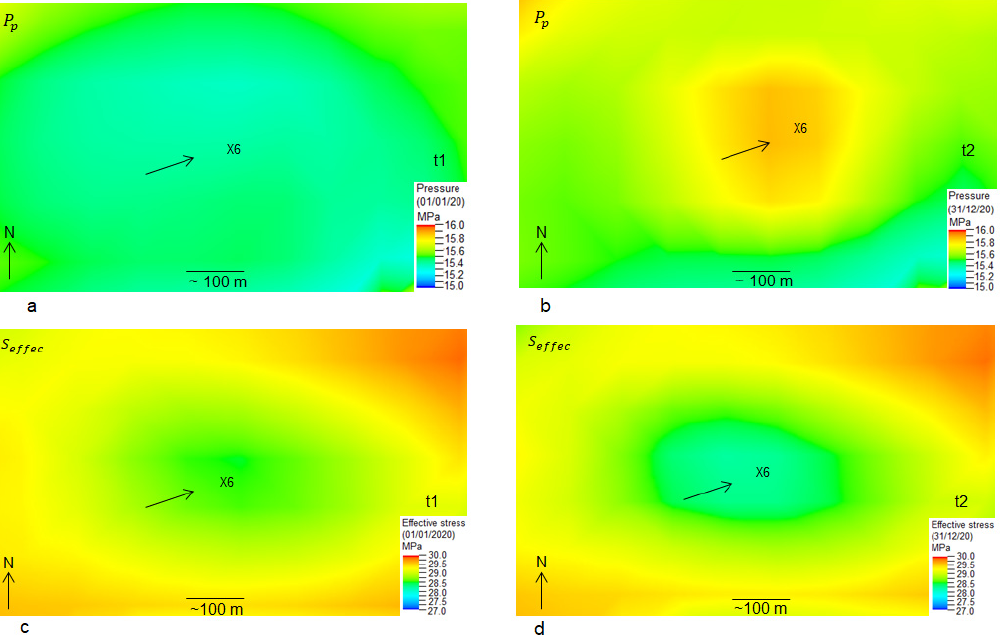
Figure 12. Pore pressure ( P p ) and effective stress ( S ef fec ) changes from t1 (1 January 2020) to t2 (31 December 2020) in short-term case with one well (X6) without a water cut-off rate of 5 m 3 /day with a random schedule. The arrows show the location of the maximum observed fluctuation in P p and S ef fec from t1 to t2. The color scale is in MPa. ( a ) is pore pressure at time t1; ( b ) is pore pressure at time t2; ( c ) is effective stress at time t1; ( d ) is effective stress at time